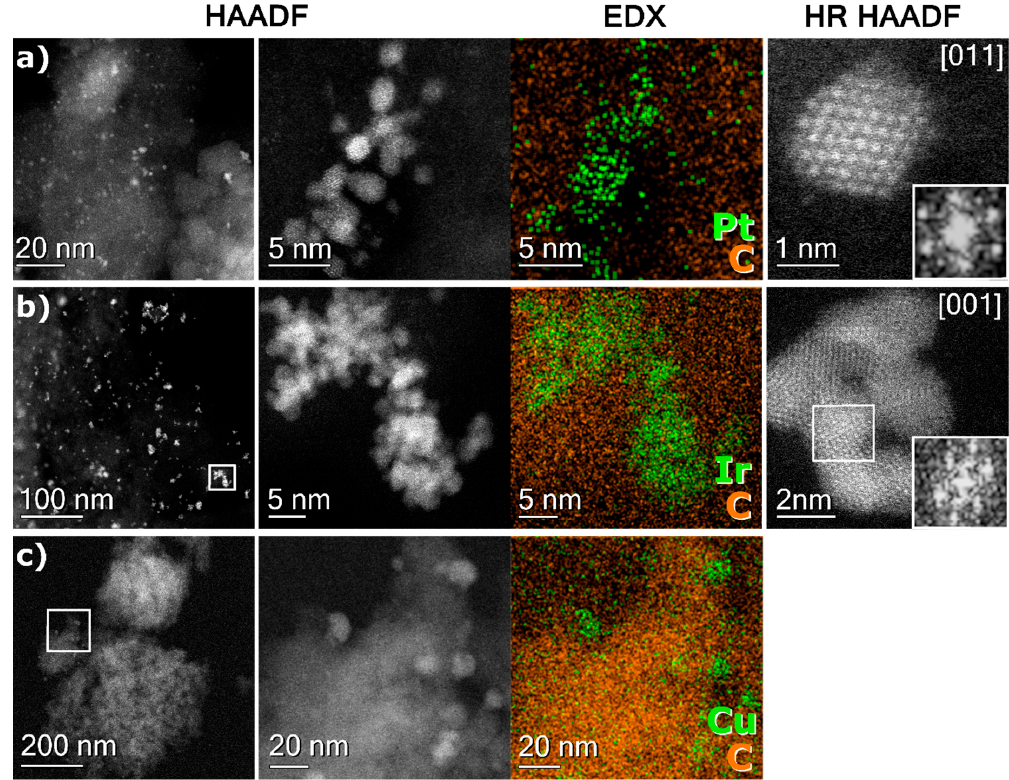
Figure 3. HAADF-STEM overviews alongside survey images of the corresponding EDX element maps of: ( a ) fresh Pt / C catalyst (top part); ( b ) fresh Ir / C catalyst (middle part); and ( c ) fresh Cu / C catalyst (bottom part). The metals are represented in green, with the C-support in orange within the EDX maps. HR HAADF-STEM images for Pt / C and Ir / C show a close up of nanoparticles with Fast-Fourier-Transform (FFT) patterns in the insets.